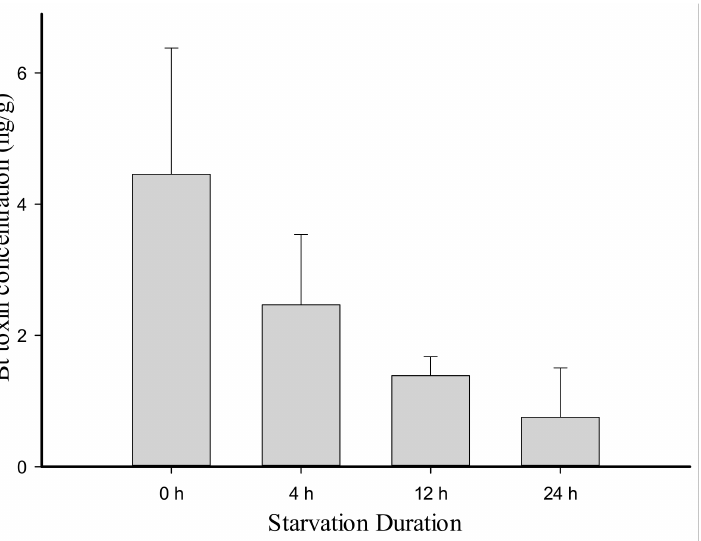
Figure 2. Changes in Bt toxin content in lacewing larvae ( Chrysopa sinica ) bodies during